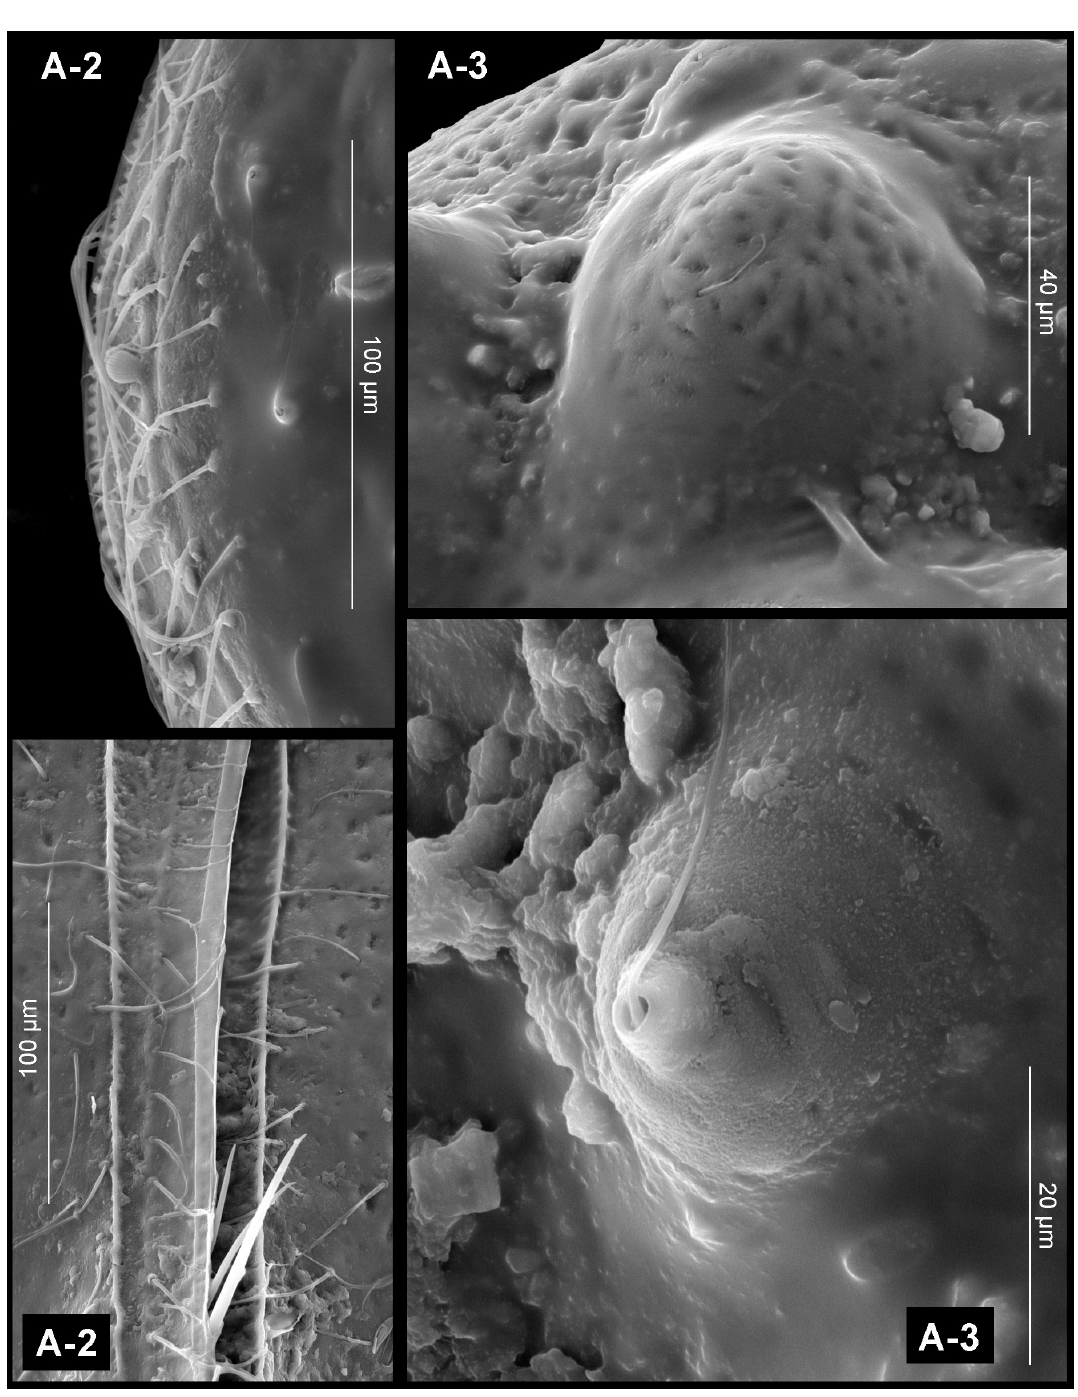
Fig. 6. Details of external views of carapaces of Bennelongia cf. nimala nov. sp. juveniles from Muggon Lake. Top left . anterior margin of A-2 carapace in left lateral view, showing the arrangement of the radial pores and their setae. Top right . enlargement of the cone of A-3 valve, showing the fine seta near its top. Bottom left . ventral view of the two valves, showing the radial pores and setae as well as the very fine and narrow external flange in both valves, but more pronounced in the RV seen on the left here. Note also that claws of some limbs are protruding from the closed valves. Bottom right . enlargement of cone and associated lip and protruding seta of an A-3 specimen. Note the presence of fine particulate material stuck to the